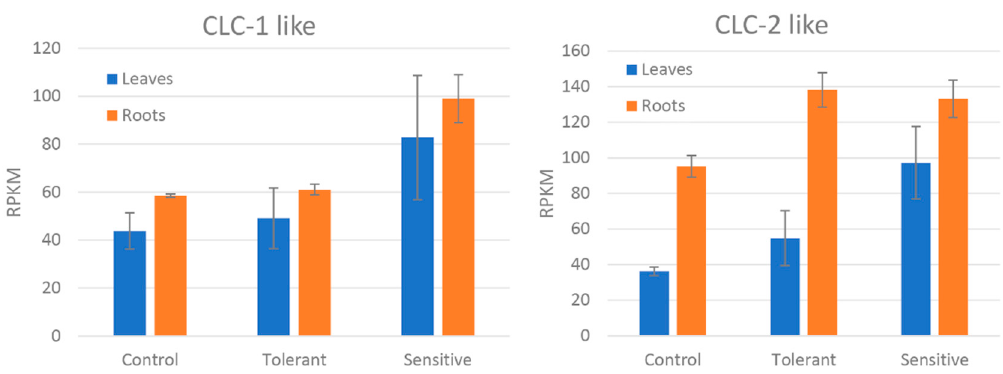
Figure 5. Reads per kilobase of transcript, per million mapped reads (RPKM) values of the differentially expressed CLC-1 and CLC-2-like genes between control, tolerant, and sensitive groups in leaves and roots. Bars represent standard deviation.